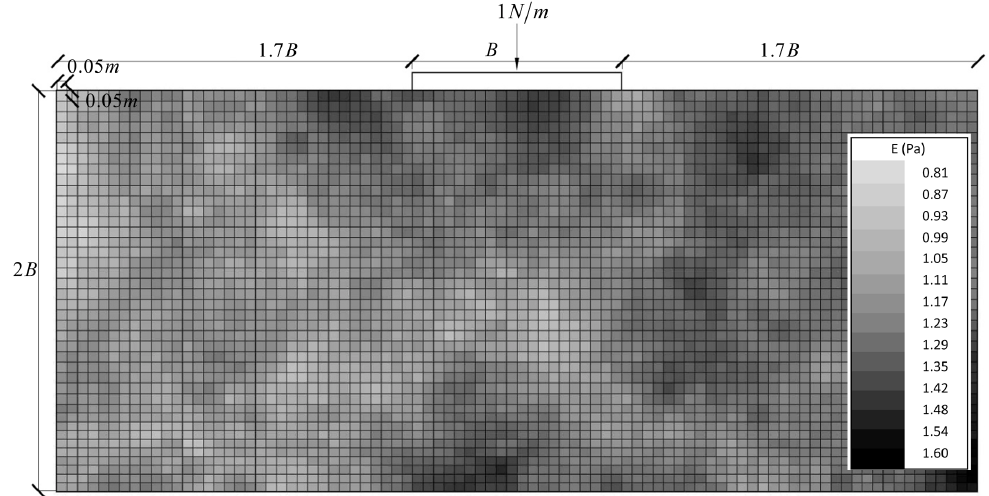
Figure 1. Typical random finite element mesh considering θ / B = 10. Figure showing the 20-element footing on the surface of a 88 × 40 (H × V) mesh.